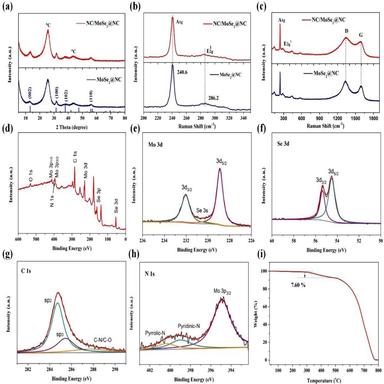
(a) XRD pattern, (b) (c) Raman spectra of MoSe2@NC and NC/MoSe2@NC; (d)-(h) XPS spectra of (d) board scan (e) Mo 3d; (f) Se 3d; (g) C 1s and (h) N 1s in the NC/MoSe2@NC; (i) TGA curve of NC/MoSe2@NC.